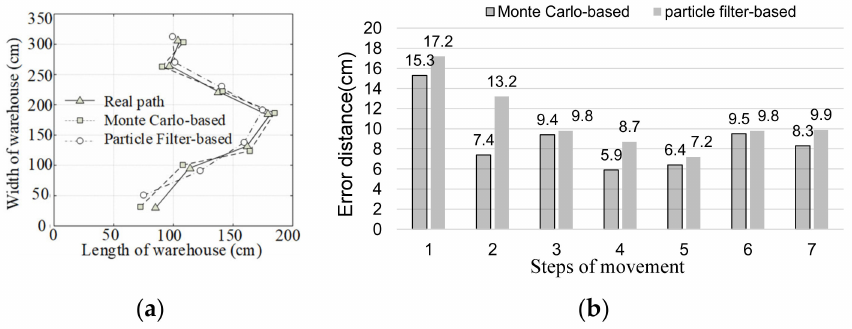
Figure 6. Simulation-based positioning results ( a ) and positioning errors ( b ) when the two antenna footprints merge into